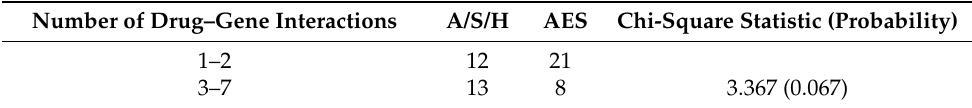
Table 7. Chi-square test of the distribution of drug – gene interactions. Number of Drug – Gene